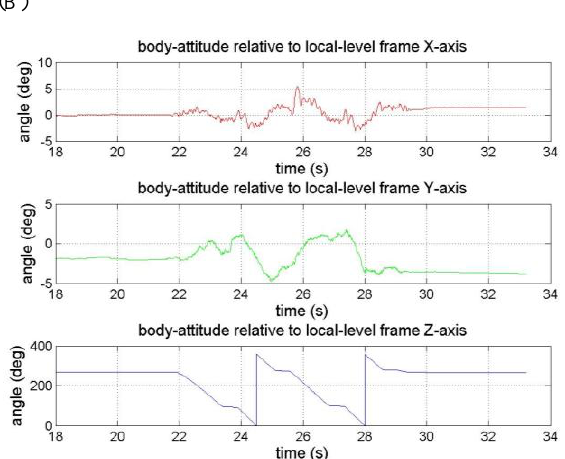
Figure 6. Pure inertial navigation results, (A) System velocity in body-frame and (B) System orientation.